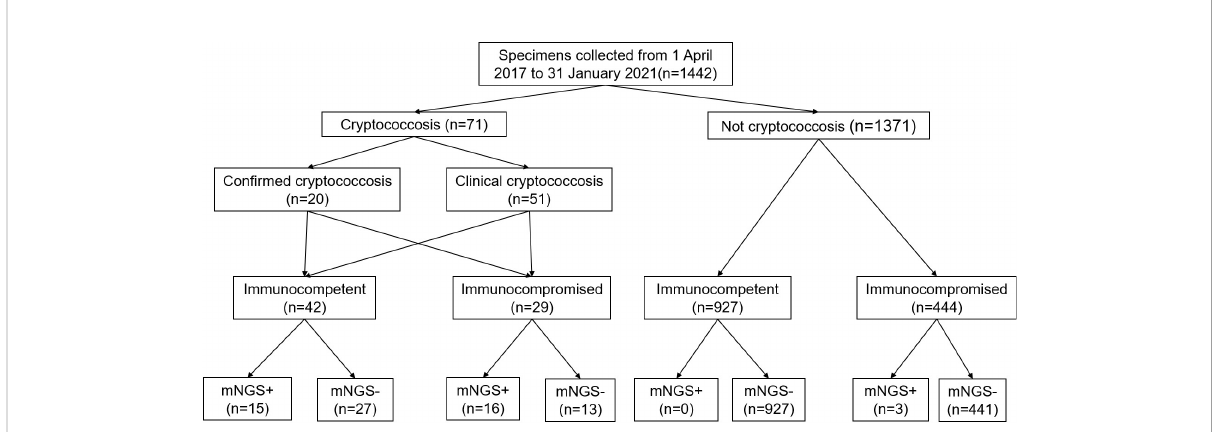
FIGURE 1 Flow chart of sample selection and classi fi cation. In total, 1442 specimens were divided into cryptococcosis and NOT cryptococcosis on the retrospective diagnosis of the corresponding patients, mNGS+ refers to strict mapping reads number(SMRN)2 for strict mapping reads number genus(SMRNG)21. mNGS, metagenomic next generation sequencing.